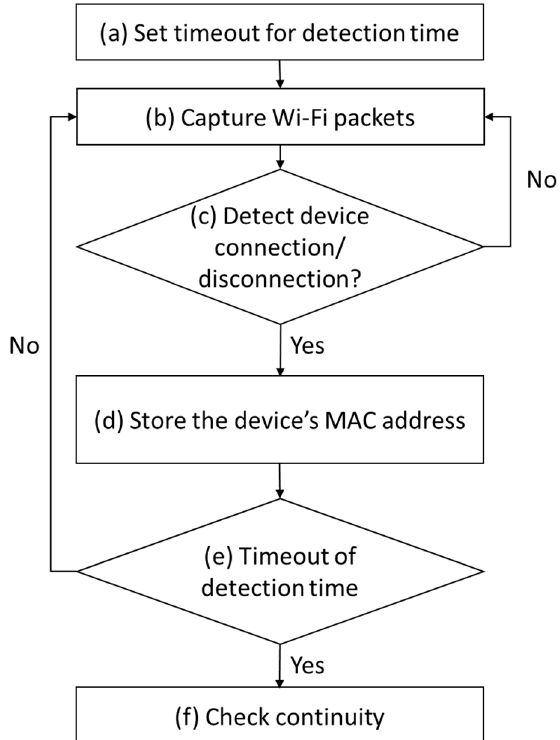
Figure 6. Wi-Fi connection data-based detection flow. ( a ) The observer sets the detection time and ( b ) captures nearby Wi-Fi packets. ( c ) When the device connection/disconnection is detected, ( d ) the MAC address of the device is stored. ( e ) After the detection time, ( f ) the continuity of the stored devices is checked. Such continuity indicates that the devices satisfy the pattern that appears when Sybil attacks are conducted (i.e., a new device connection after a device disconnection).